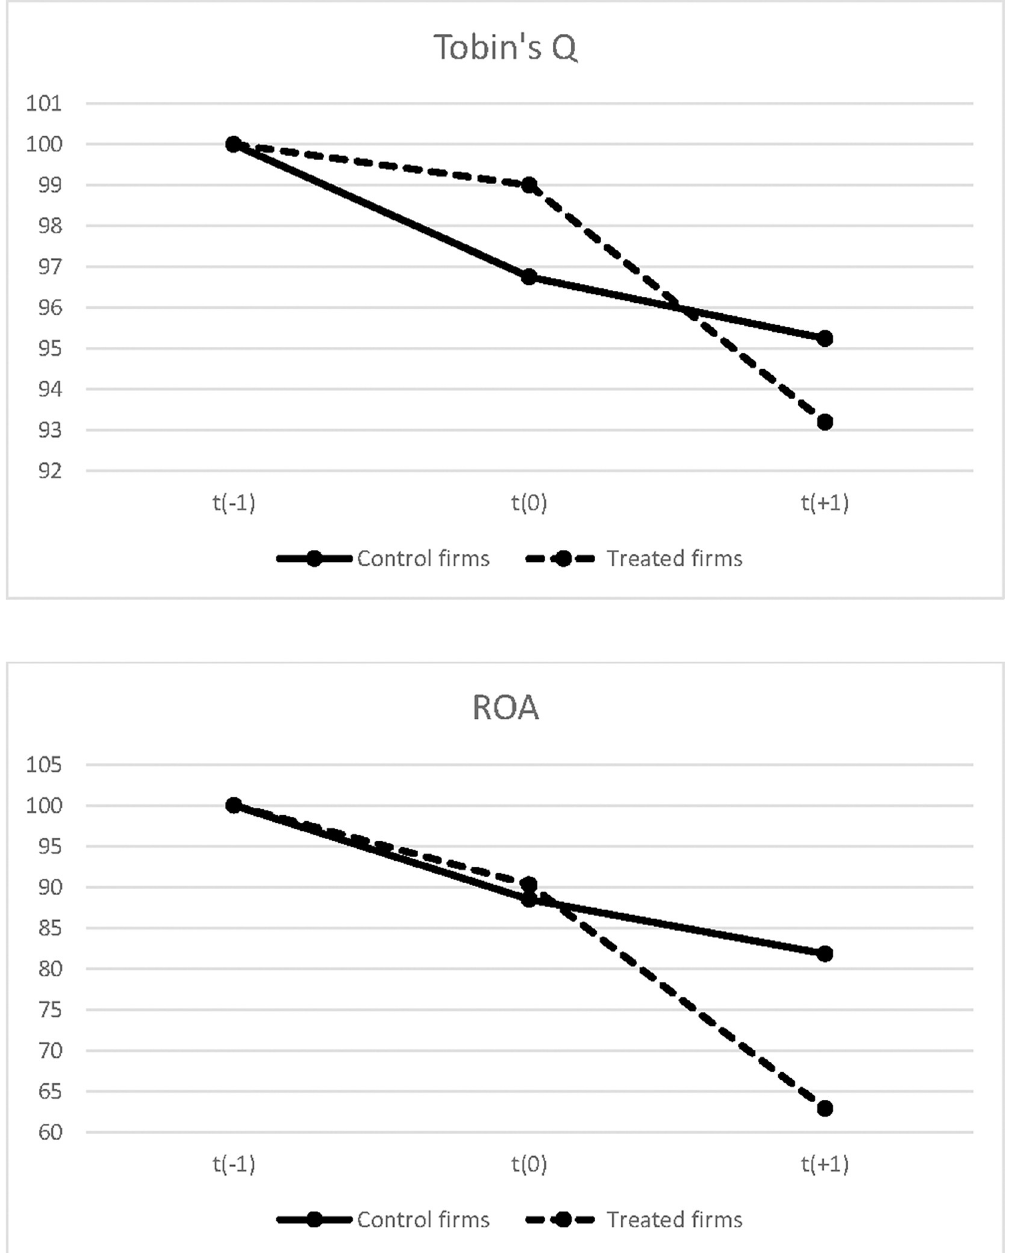
Fig 2. Performance Trends for firms exposed vs not exposed to flooding. This figure plots the average Tobin’s Q and ROA values in the year prior to the flooding year (i.e., year t(-1) ), the flooding year (i.e., year t(0) ) and the year after the flooding year (i.e., year t(+1) ) for both the treated firms that experience an increase in flood ratio in year t(0) and the control firms that do not experience any flooding during these three years. The levels of Tobin’s Q and ROA in year t(−1) are rescaled to 100 for the ease of comparison between the two